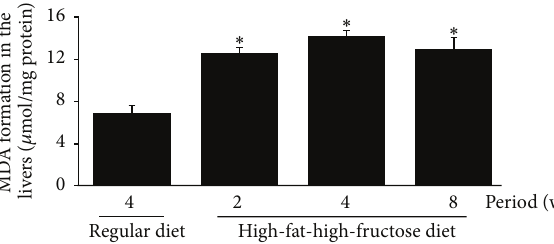
Figure 5: Effects of a high-fat, high-fructose diet on lipid peroxidation in the mouse livers. Mice were fed a commercial standard diet for 4 weeks, and a high-fat, high-fructose diet (HFFD) was administered intragastrically for 2, 4, or 8 weeks. The mice were sacrificed 24 h after the last treatment, and their livers were immediately excised to determine the levels of malondialdehyde (MDA). The data are presented as the mean ± SD ( 𝑛 = 5 ). Significant differences were determined using a one-way analysis of variance (ANOVA) followed by Tukey’s post hoc test. ∗ 𝑝 < 0.05 versus the regular diet